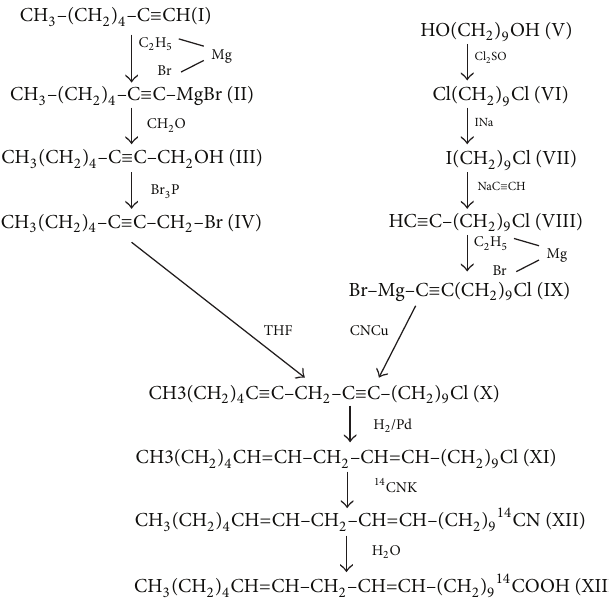
Figure 5: Scheme for the organic synthesis of 1- 14 C eicosa-11,14-dienoic